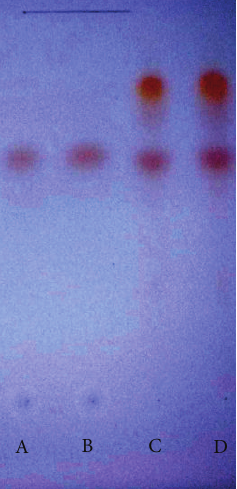
Figure 1: HPTLC plates of taurine. A, B: standard; C, D: samples.